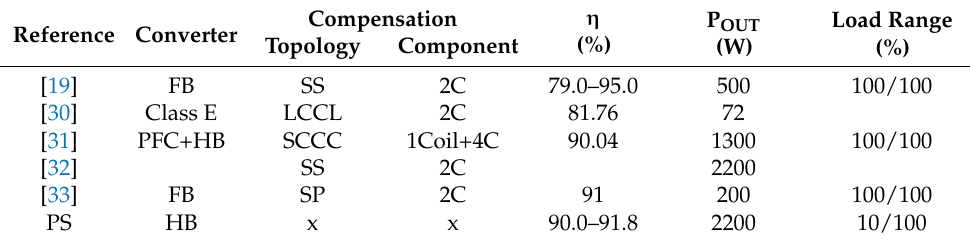
Table 2. Literature survey on WPT small home